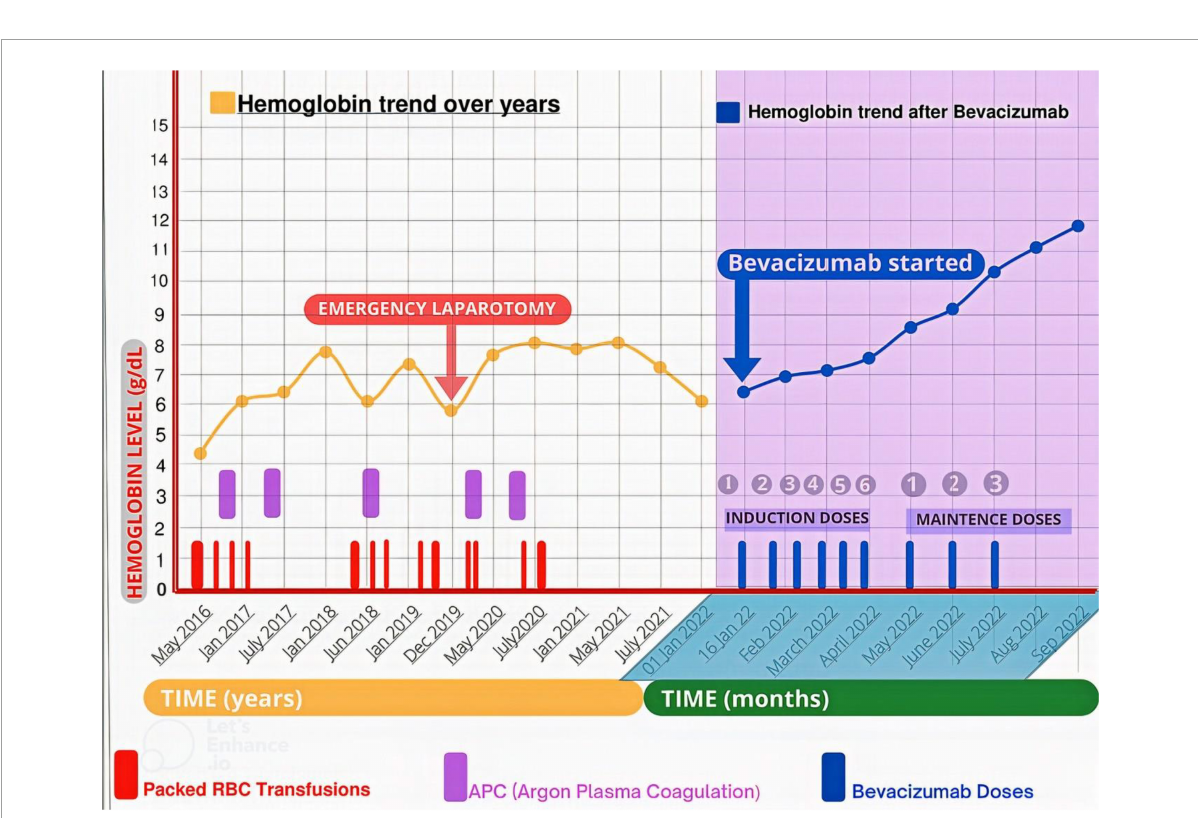
FIGURE3 The trend in hemoglobin levels before and after bevacizumab initiation. The patient received multiple Packed RBC transfusions, and underwent multiple endoscopic argon plasma coagulation (APC) and an emergency laparotomy (for extensive GI bleed) to maintain hemoglobin level before bevacizumab commencement. While after initiating bevacizumab, he became transfusion independent and had a progressive uptrend in his hemoglobin level from 6.4 to 12 mg/dL at 8 months